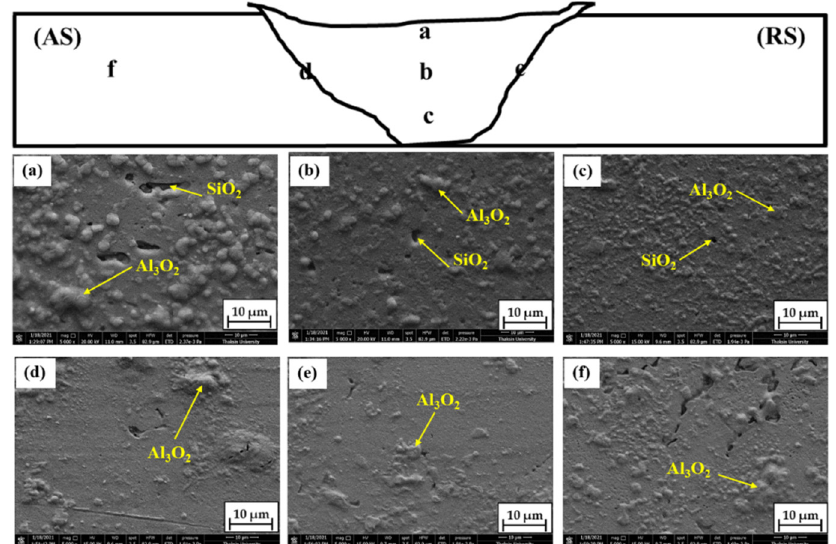
Figure 19. Microstructural analysis of the welded joints using FE-SEM: ( a ) SEM at a; ( b ) SEM at b; ( c ) SEM at c; ( d ) SEM at d; ( e ) SEM at e; ( f ) SEM at f.